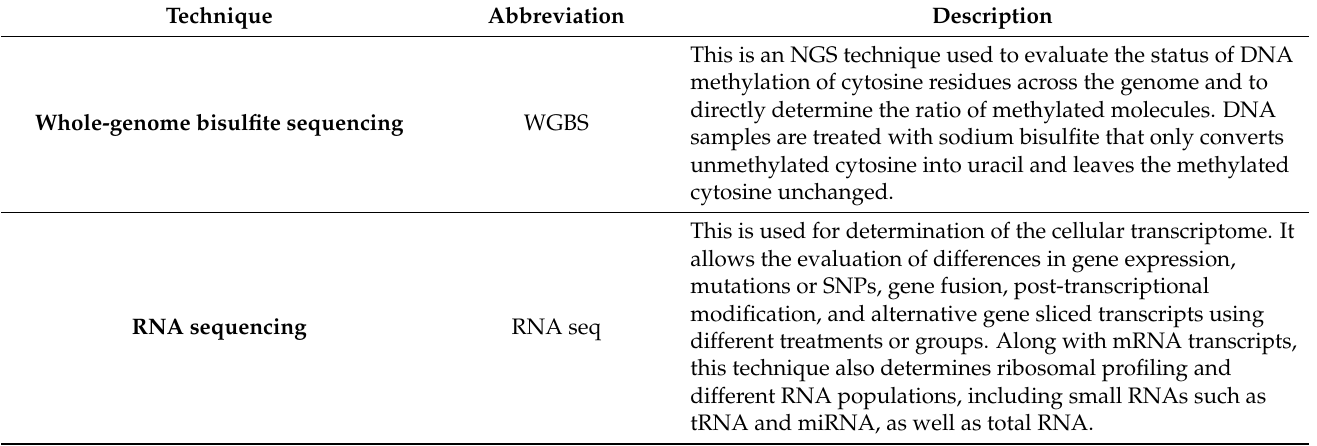
Table 3. Techniques for epigenetic studies